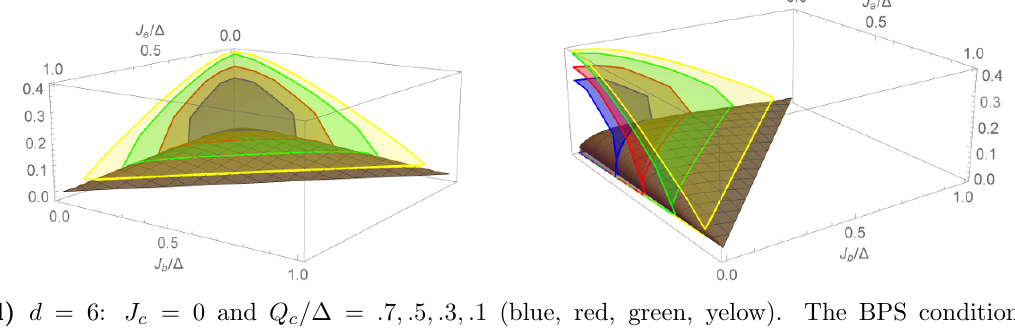
Figure 5. Plots of ( (cid:25) (cid:1)) (cid:0) 1 log (cid:26) [(cid:1) ; J a ; J b ; ( J c ) ; Q ]. Gray surfaces are S BH = ( (cid:25) (cid:1)) for corresponding BPS black holes which coincide with our bound at the BPS condition. Beyond this surface, the bound vanishes and no states are allowed (color online).